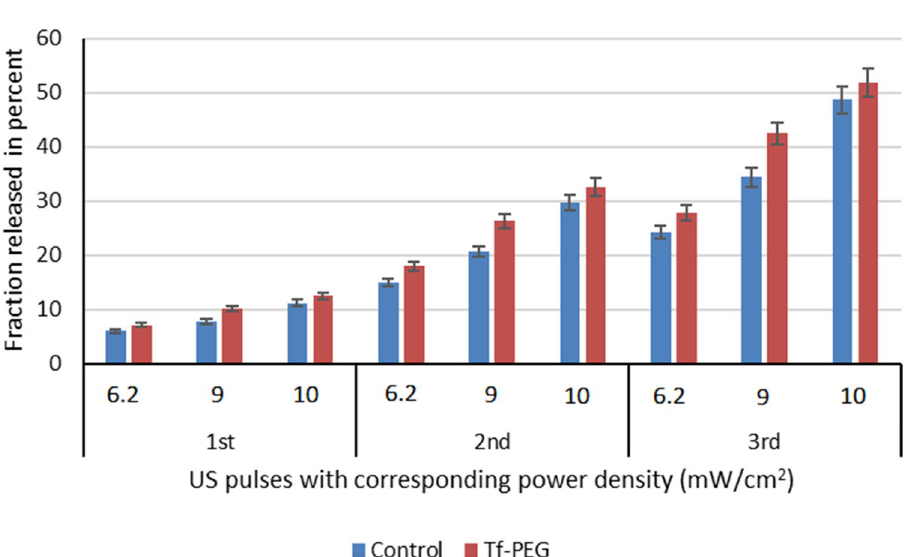
Figure 8. Percentage calcein release from both the control and Tf-PEG liposomes following the exposure to the first four pulses at the different power densities 6.2, 9 and 10 mW/cm 2 expressed in terms of